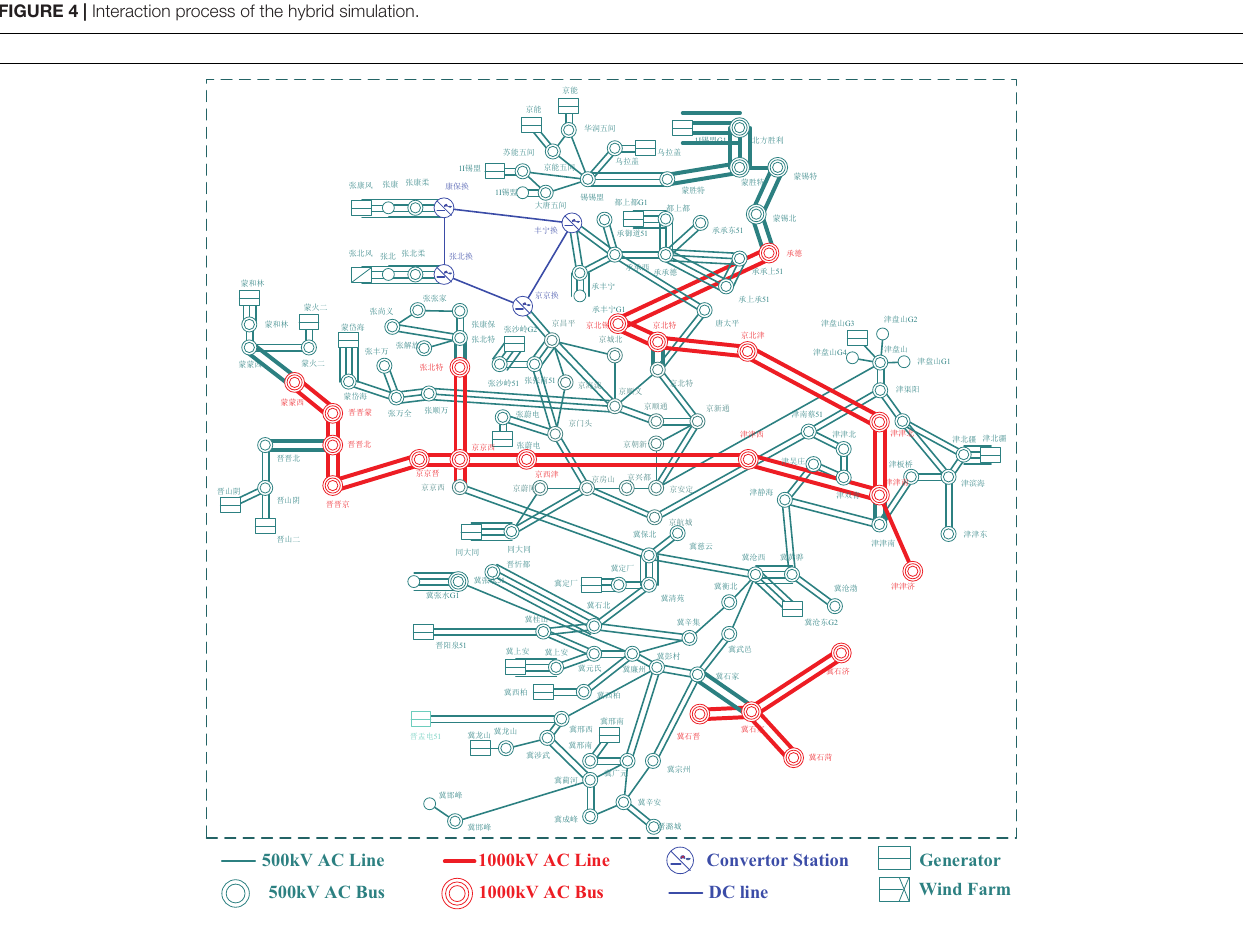
FIGURE 5 | Topology of the Zhangbei multi-terminal VSC-HVDC transmission system.